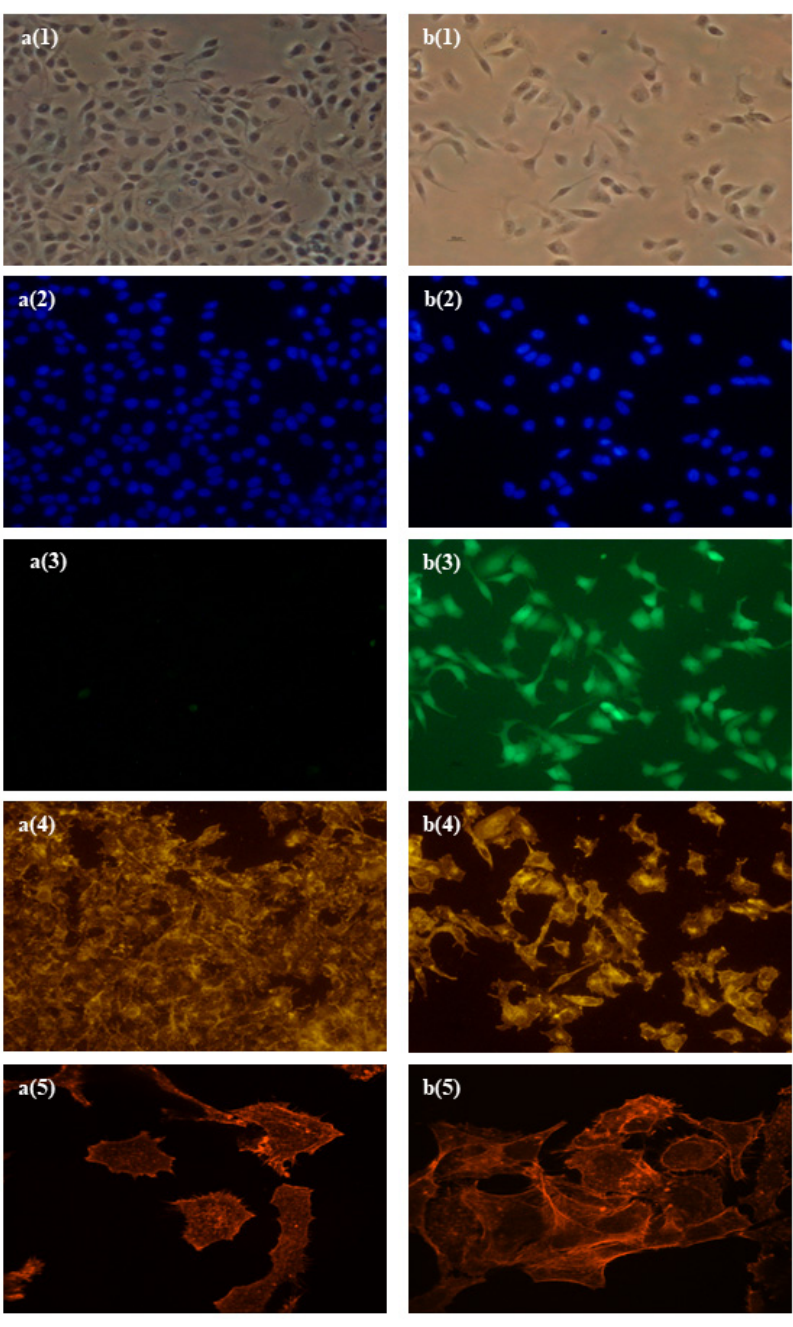
Figure 2. Microphotographs showing parental cells NCTC_2544 ( a ) and engineered cells NCTC_2544_AcGFP ( b ). Panels ( a(1) , b(1) ) are microphotographs with white light to show cell morphology and shape; panels ( a(2) , b(2) ) are microphotographs with nuclei counterstained with DAPI; panels ( a(3) , b(3) ) are microphotographs with fluorescence light to visualize constitutive green fluorescence; panels ( a(4) , b(4) ) are microphotographs with fluorescence light to visualize actin fiber architecture (magnitude 20×; panels ( a(5) , b(5) ) are microphotographs with fluorescence light to visualize actin fiber architecture (magnitude 60×).